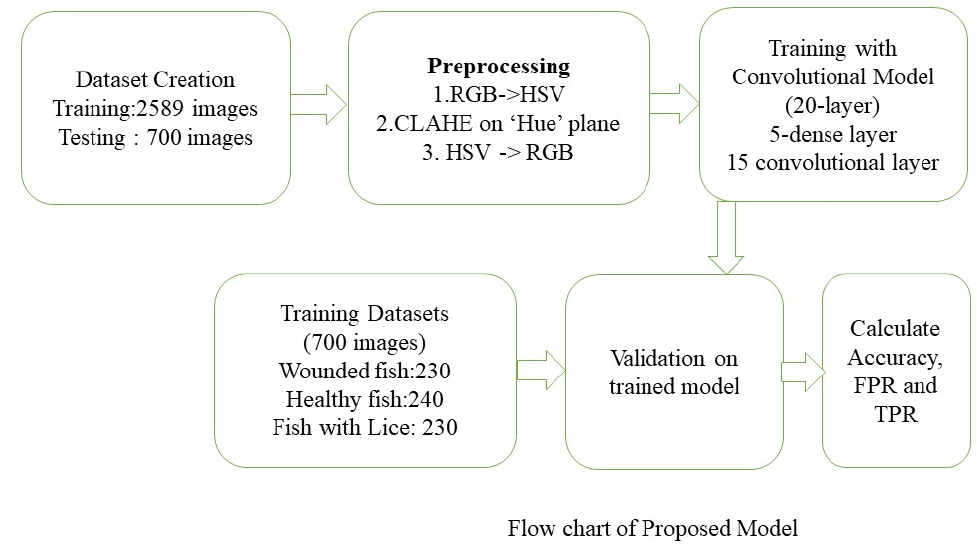
Figure 4. Flow chart of the proposed methodology.